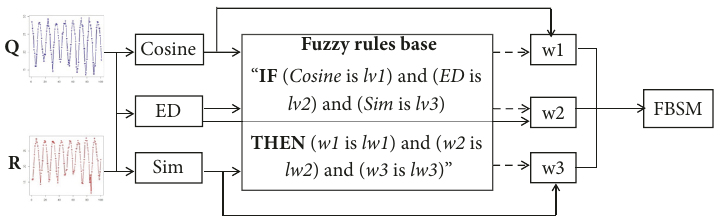
Figure 1: Computing scheme of the new similarity measure.